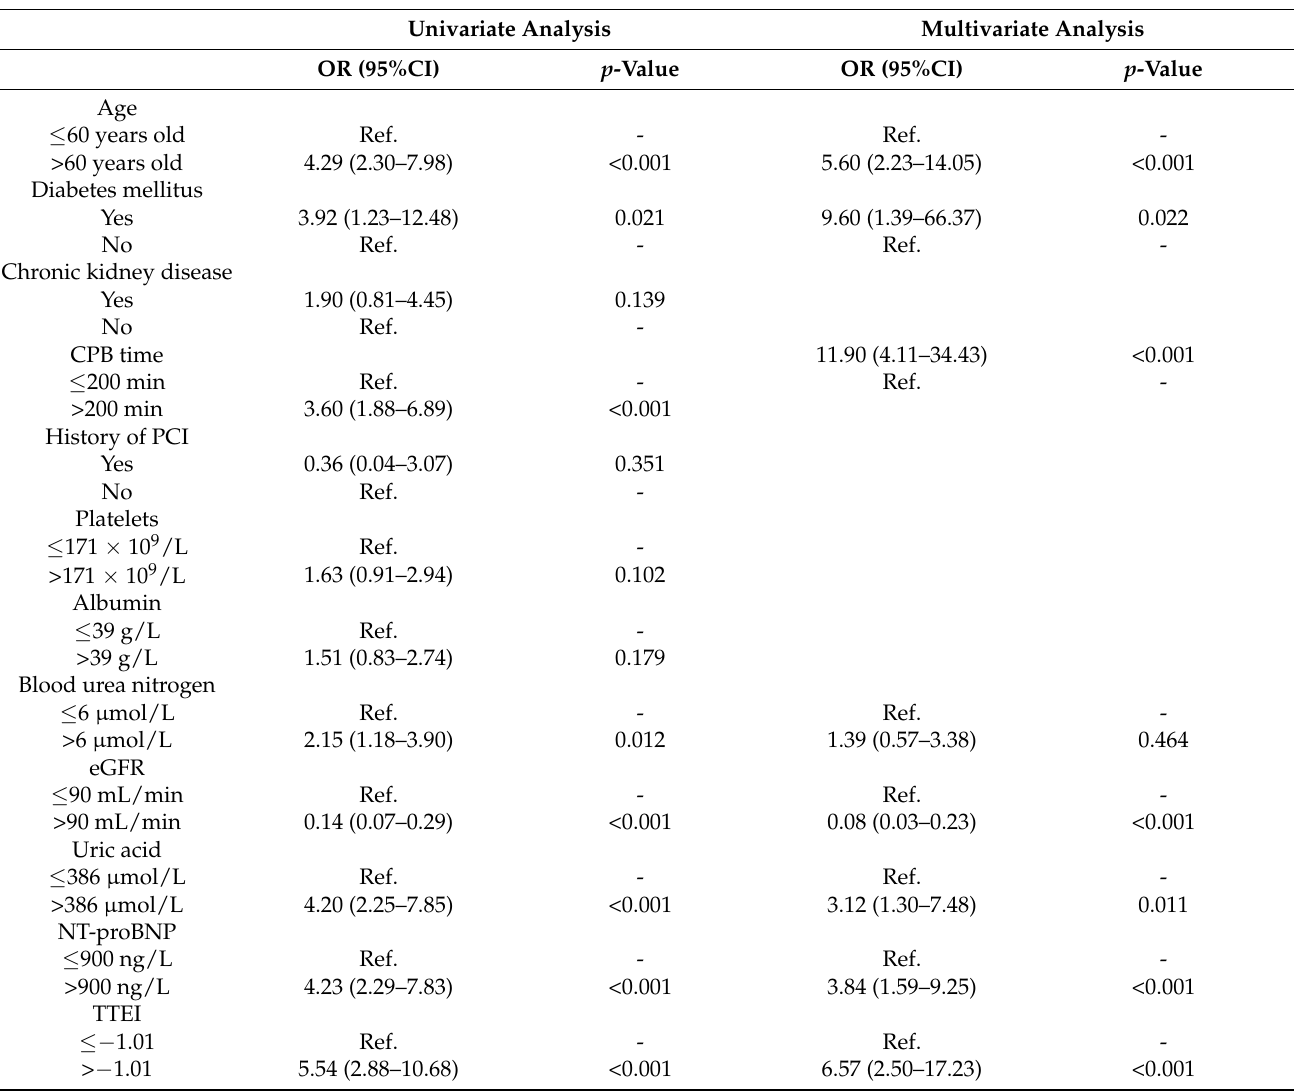
Figure 6. The predictive nomogram for CVS−AKI . Table 3. Logistic regression analysis for the predictors of CVS−AKI selected by LASSO regression.